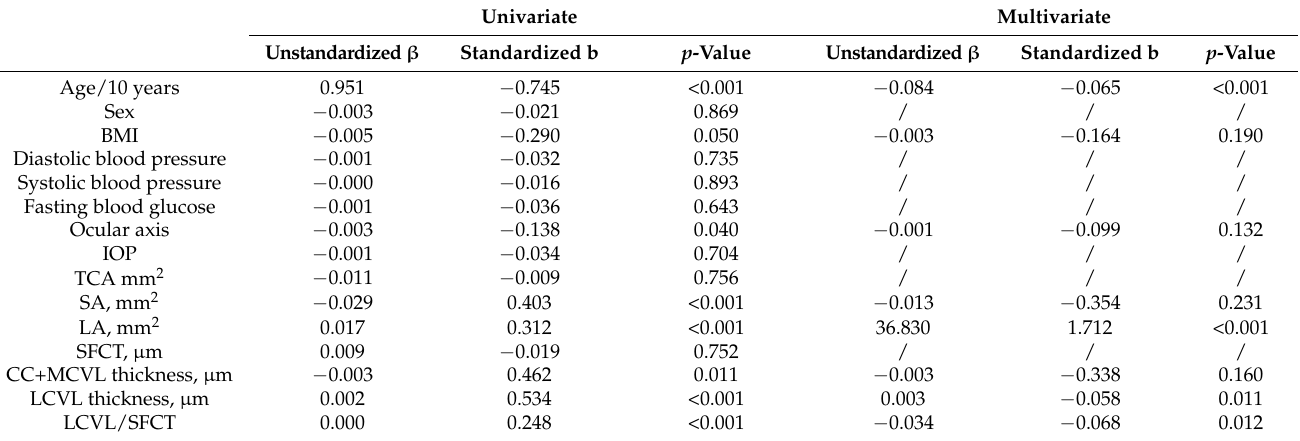
Table 4. Linear regression analysis of ocular and systemic factors correlated with CVI.